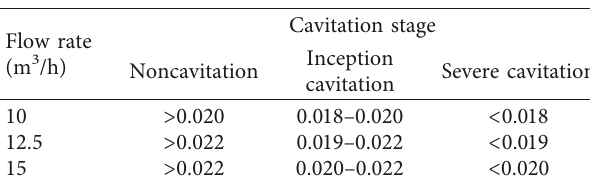
Table 3: Cavitation numbers for different cavitation stages.